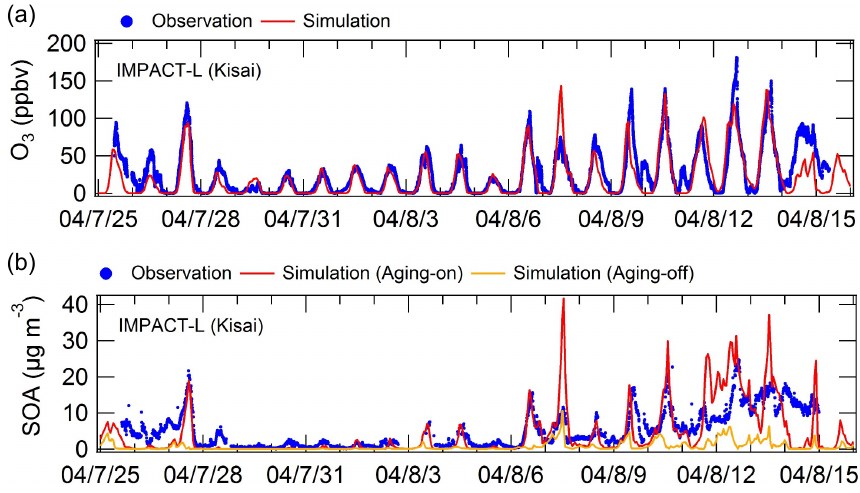
Figure 4. Time series of the observed and simulated (a) O 3 volume mixing ratios and (b) SOA mass concentrations at Kisai during the IMPACT-L campaign. SOA values were simulated with and without aging. Table 5. Statistics of concentrations of chemical species at the surface measurement sites. Station Period Species Units Mean concentration NMB R b Observation Calculation a Calculation a (%) b (Aging-on) (Aging-off) Komaba O 3 Kisai